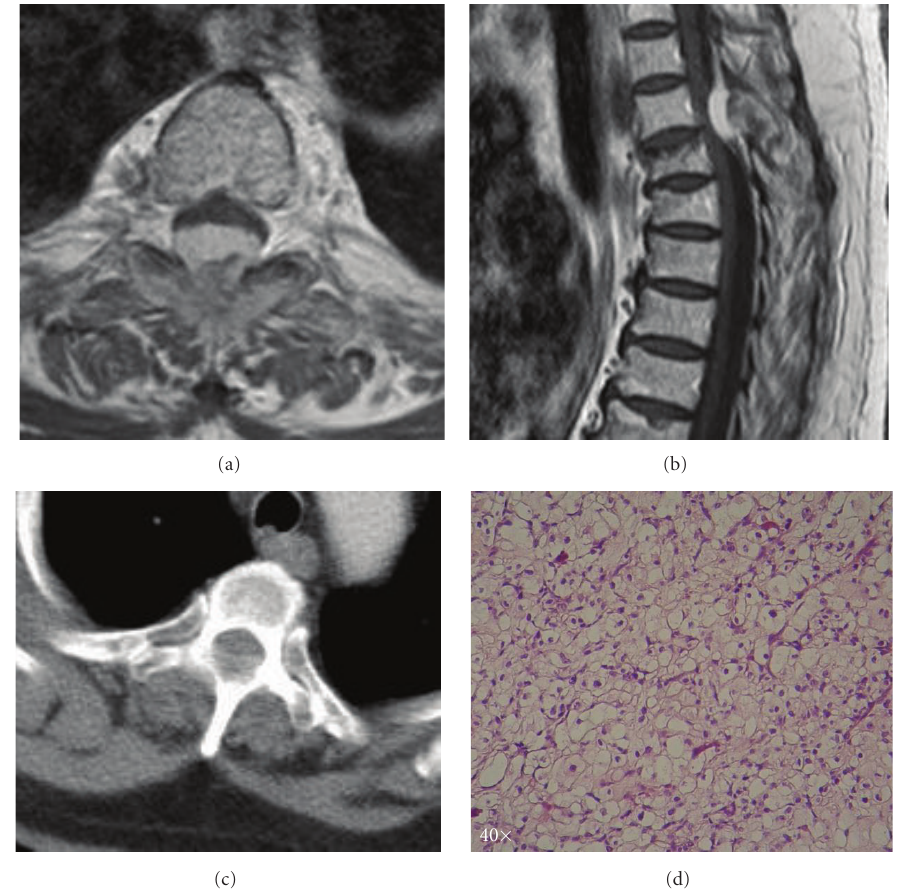
Figure 1: (a) Axial T2 weighted MR image of the lesion at Th3 level, demonstrating significant spinal cord compression; (b) Sagittal contrast enhanced T1 weighted MR image of the lesion, showing spinal cord compression at Th3-Th4 level; (c) Axial CT scan of the lesion at Th3 level, demonstrating spinal canal involvement, bony erosion, and paravertebral extension of the tumor; (d) H/E × 40 Clear cell chondrosarcoma characterised by tumor cells with variably clear